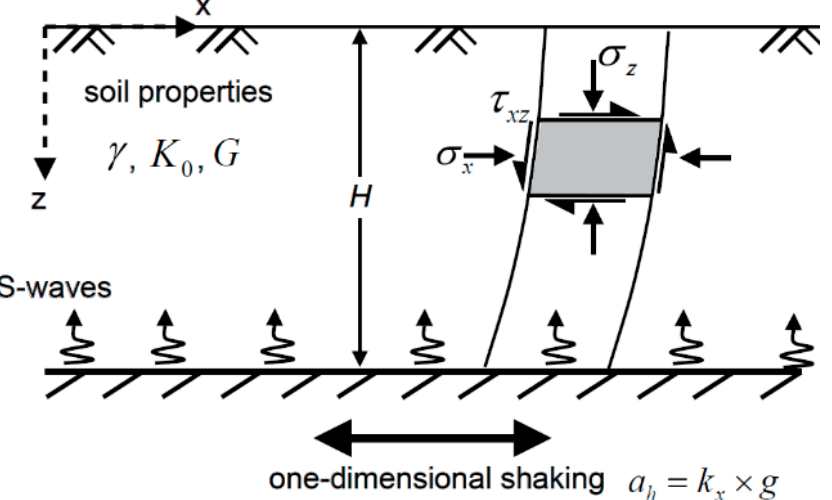
Figure 27. Shear-beam idealisation of infinite lateral extent stratum overlying a bedrock subjected to one-dimensional shaking.